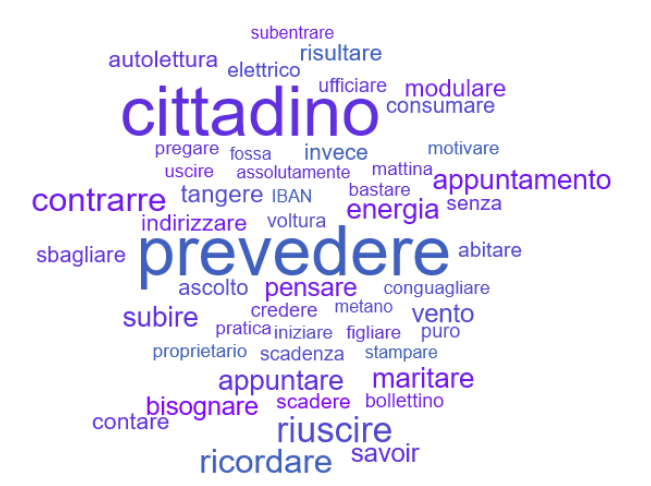
Figure 14. World Cloud of topic